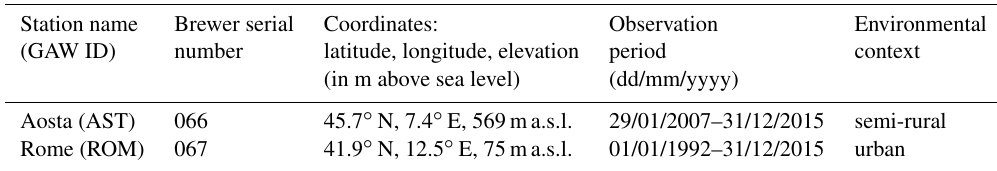
Table 1. Characteristics of the two Italian Brewer sites.